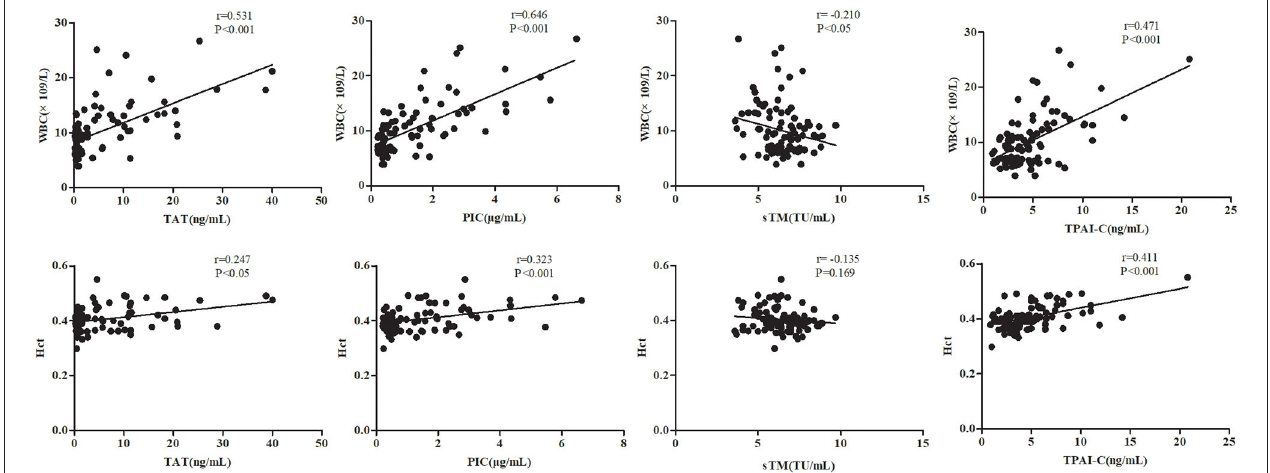
FIGURE 2 | Correlations between the thrombin-antithrombin complex, plasmin alpha2-plasmin inhibitor complex, soluble thrombomodulin, and tissue plasminogen activator-inhibitor complex levels and white blood cell and hematocrit levels. TAT, thrombin-antithrombin complex; PIC, plasmin alpha2-plasmin inhibitor complex;